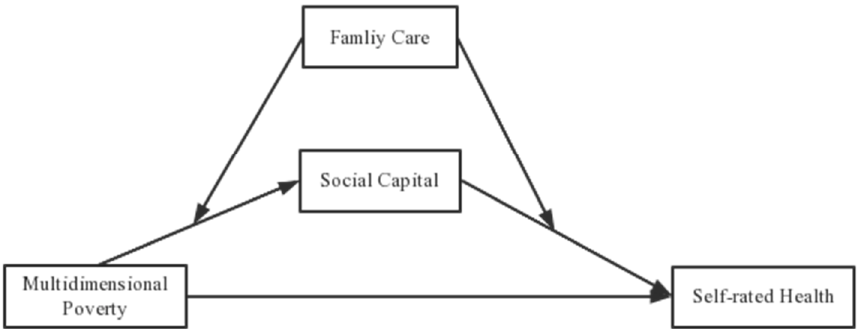
Figure 1. Hypothetical model diagram of the mediating role of social capital and the moderating role of family care.